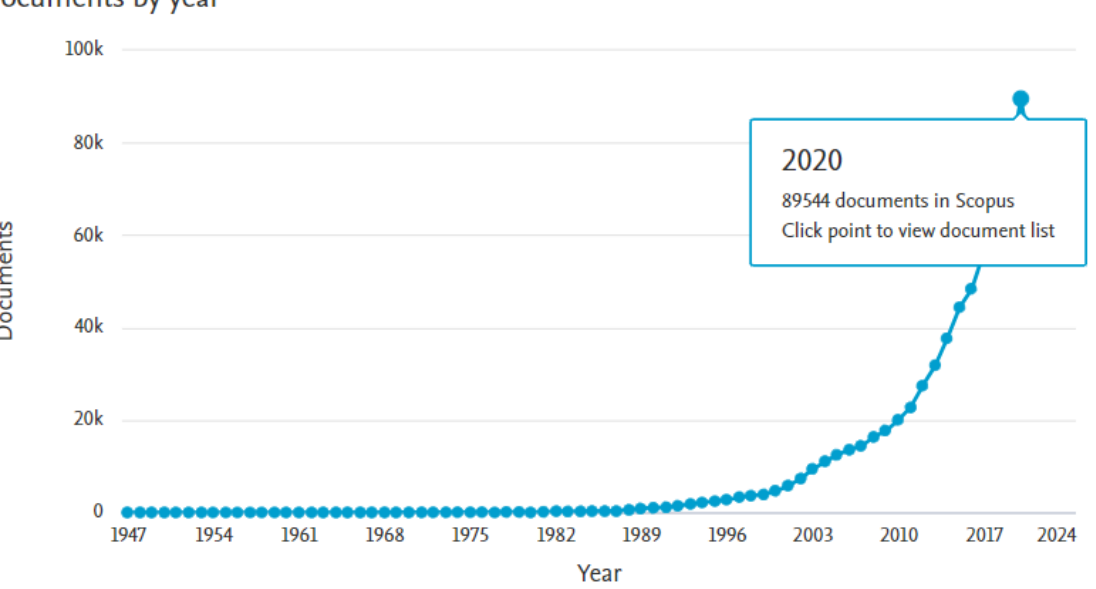
Figure 1. The search results for TITLE-ABS-KEY (cohort AND analysis) query by year in the Scopus database for the 1947–2021 period as of 20 October 2021.